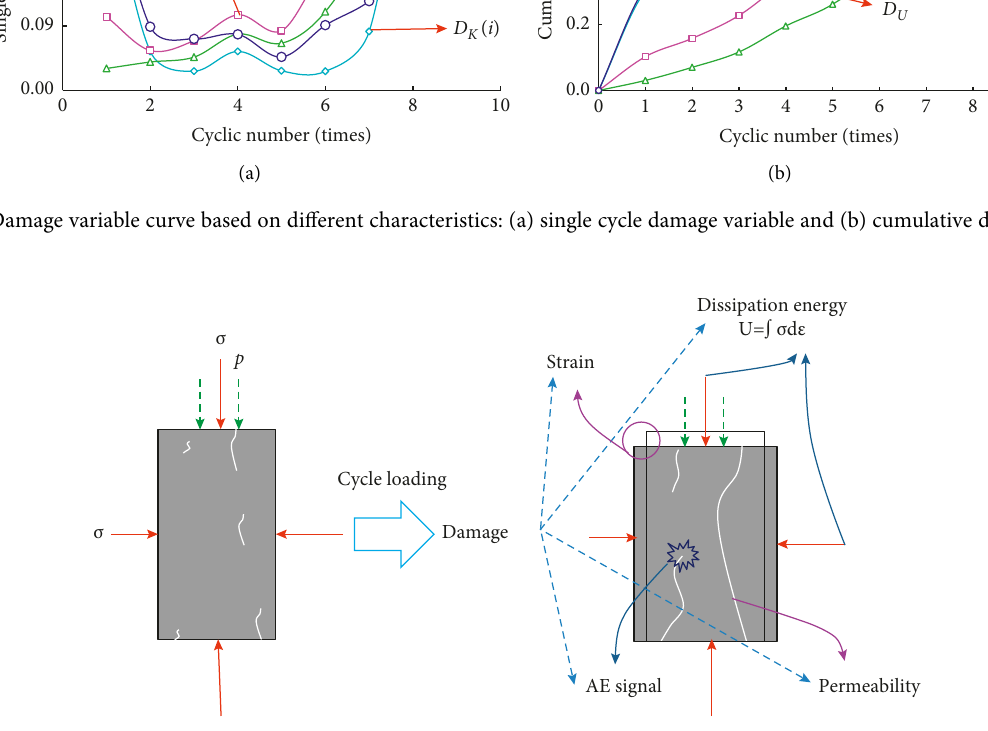
Figure 11: The damage of coal characterized in the form of different variables under cycle